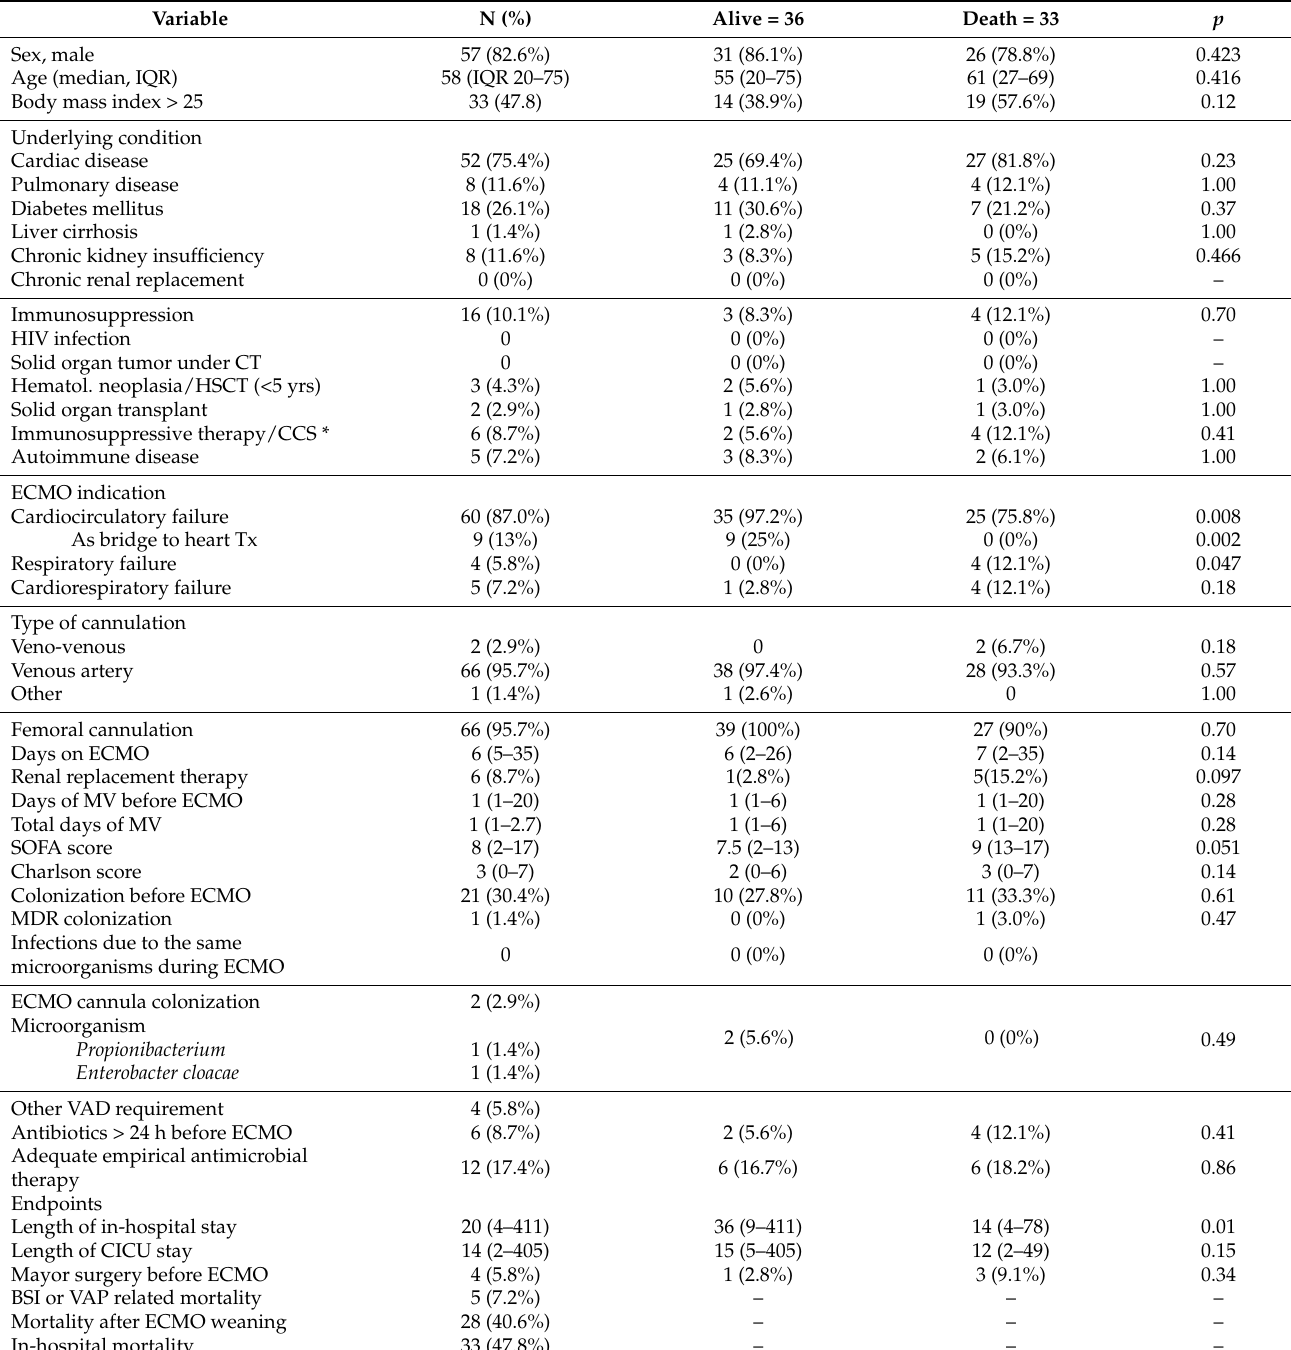
Table 4. Univariate analysis of the risk factors for